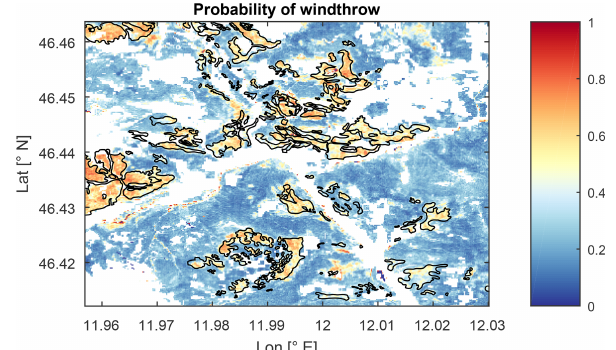
Figure 6. Remote sensing classification of windthrows. Proba- bility of windthrow obtained from random forest classification of Sentinel-2 reflectance bands and their tasselled cap transformation in a sampled area of the Dolomites in northern Italy affected by windstorm Vaia in October 2018. Black polygons show the actual wind